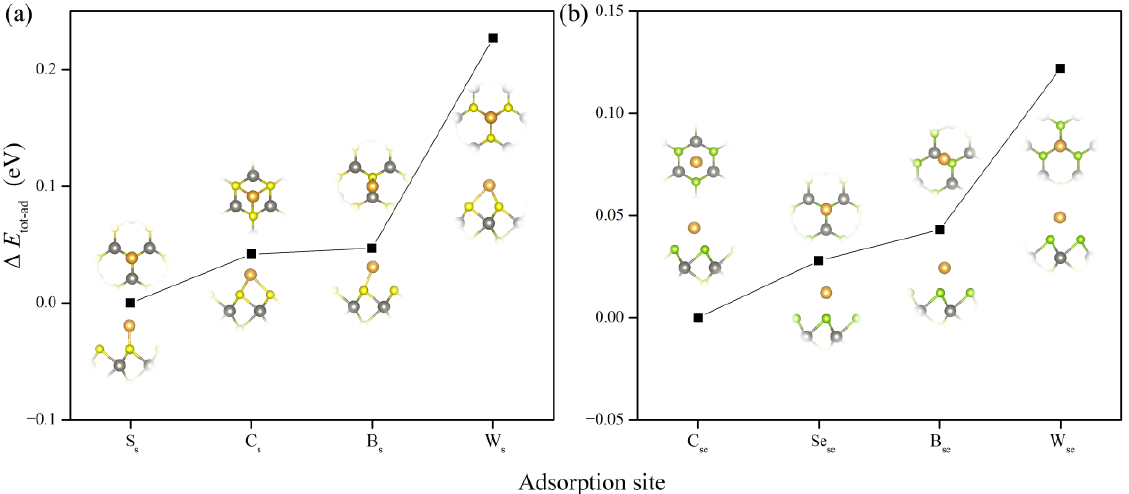
Figure 1. Relative total energy ( ∆ E ) of single Au atom adsorbed WSSe monolayer with the four adsorption sites on the ( a ) S and ( b ) Se layers, respectively. For each case, the energy of the system with the lowest total energy is taken as the reference value. The insets show the top view (above) and the side view (below) of the optimized structures of these systems. The yellow, green, grey, and golden balls represent S, Se, W and Au atoms, respectively.